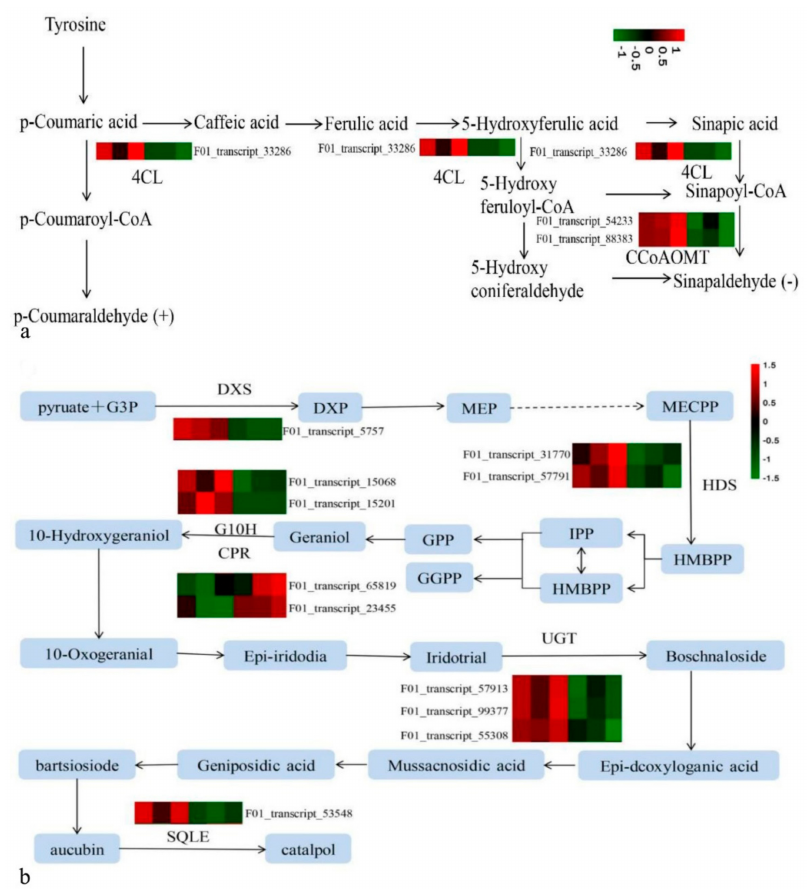
Figure 6. Regulation of DEGs on DAMs via metabolic pathways. ( a ) Regulation of DEGs on DAMs ( p -coumaraldehyde and sinapoyl aldehyde) in Phenylpropanoid biosynthesis (Figure S8). +: up-regulated. − : down-regulated. 4CL: 4-coumarate-CoA ligase (F01_transcript_33286) (EC 6.2.1.12). CCoAOMT: caffeoyl-CoA O-methyltransferase (F01_transcript_54233, F01_transcript_88383) (EC 2.1.1.104). ( b ) Regulation of DEGs on catalpol in its biosynthesis pathway. DXS: 1-deoxy-